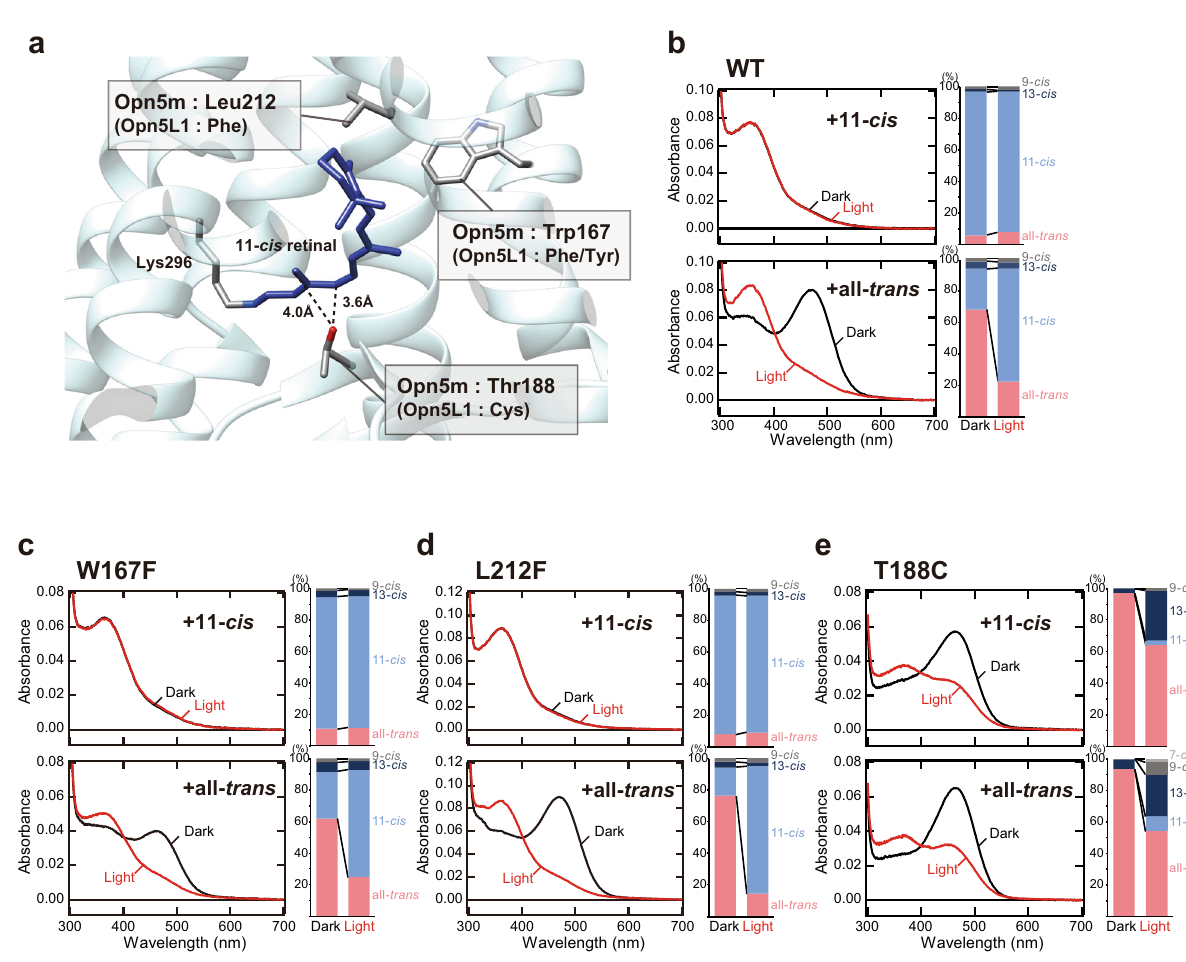
Fig. 1 Binding selectivity of retinal isomers in wild-type and W167F, L212F, and T188C mutant Opn5m proteins. a Different amino acid residues around the retinal between Opn5m and Opn5L1 subgroups. A structural model was constructed based on the crystal structure of squid rhodopsin (PDB: 2z73) visualized using UCSF Chimera 27 . Squid rhodopsin has serine and phenylalanine at positions 188 and 212 (based on the bovine rhodopsin numbering system) (Supplementary Fig. 1), which were replaced by threonine and leucine in this model. b - e (left) Absorption spectra of Opn5m wild-type ( b ) and W167F ( c ), L212F ( d ), and T188C ( e ) mutant proteins puri fi ed after the addition of 11- cis or all- trans retinal to the collected cell membranes. The spectra were recorded at 0 °C in the dark (curve 1) and after yellow light (>500 nm) irradiation (curve 2). Spectral change by light irradiation is shown in left panels of Supplementary Fig. 2a – h. (right) Retinal con fi guration changes of Opn5m wild-type ( b ) and W167F ( c ), L212F ( d ), and T188C ( e ) mutant proteins puri fi ed after the addition of 11- cis or all- trans retinal to the collected cell membranes. The retinal isomers before and after yellow light (>500 nm) irradiation were analyzed with HPLC after extraction of the chromophore as retinal oximes (right panels of Supplementary Fig. 2a – h). The negative peak in the visible region of the difference spectrum calculated before and after yellow light irradiation of the wild-type (Supplementary Fig. 2e) corresponds to λ max of the all- trans retinal bound form (474 nm). λ max of the all- trans retinal bound form of the mutant proteins calculated from their difference spectra (Supplementary Fig. 2f – h) are 470 nm (W167F), 475 nm (L212F), and 470 nm